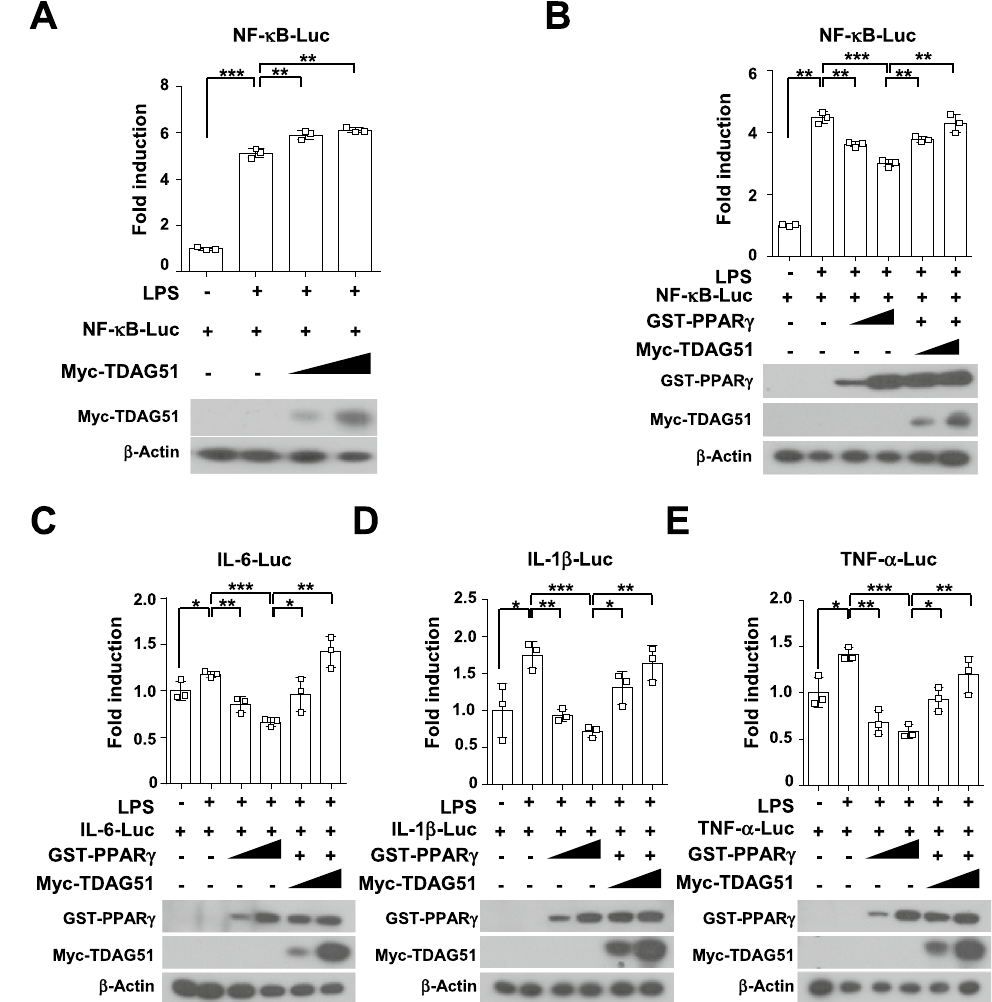
Figure 6. PPARγ-mediated inhibition of LPS-induced NF-κB and proinflammatory cytokine promoter activities is restored by TDAG51 expression. ( A ) LPS-induced NF-κB promoter activity is enhanced by TDAG51 expression. Reporter plasmids [NF-κB-Luc (0.2 μg) and pcDNA3.1/His/LacZ (0.1 μg)] were cotransfected with Myc-tagged TDAG51 expression plasmid [Myc-TDAG51 (0.3–1.0 μg)] into 293/TLR4-MD2-CD14 cells. The transfected cells were stimulated with 1 μg/ml LPS for 24 h and then analyzed using luciferase assays (top panel). The expression of epitope-tagged plasmids was analyzed by immunoblotting against anti-epitope antibodies (bottom panel). β-Actin was used as the loading control. ( B ) PPARγ-mediated inhibition of LPS- induced NF-κB promoter activity is restored by TDAG51 expression. Reporter plasmids [NF-κB-Luc (0.2 μg) and pcDNA3.1/His/LacZ (0.1 μg)] were cotransfected with epitope-tagged expression plasmids [GST-PPARγ (0.25–1.0 μg), Myc-TDAG51 (0.3–1.0 μg)] into 293/TLR4-MD2-CD14 cells. The luciferase activity (top panel) and the expression of epitope-tagged plasmid (bottom panel) were analyzed. ( C ) PPARγ-mediated inhibition of LPS-induced IL-6 promoter activity is restored by TDAG51 expression. ( D ) PPARγ-mediated inhibition of LPS-induced IL-1β promoter activity is restored by TDAG51 expression. ( E ) PPARγ-mediated inhibition of LPS-induced TNF-α promoter activity is restored by TDAG51 expression. * P < 0.05. ** P < 0.01. *** P <